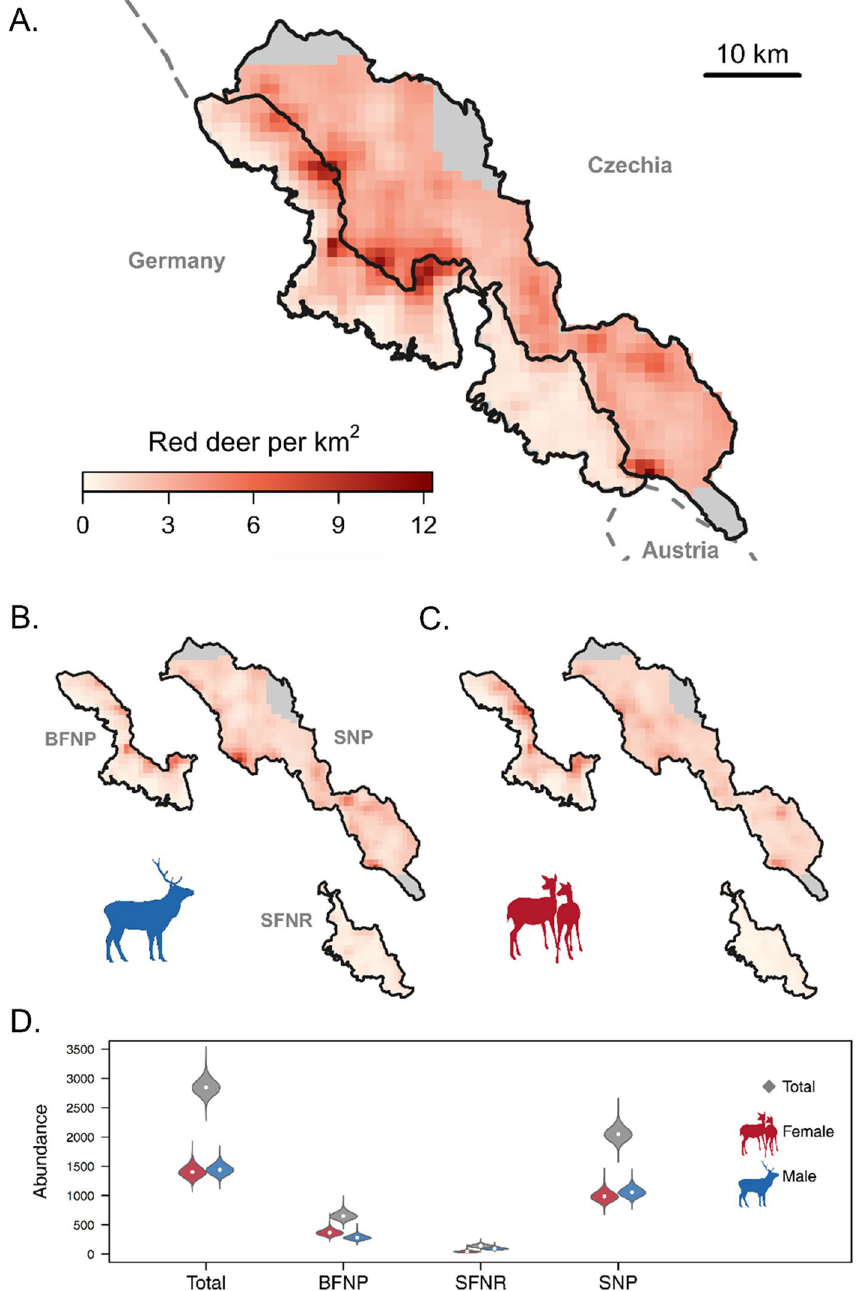
Figure 2. Density maps ( A – C ) and abundance estimates (plot D ) for red deer Cervus elaphus across the Bohemian Forest Ecosystem in summer, June and July, 2018. Population estimates are broken down into sex- specific estimates ( B male, C female deer) for the three administrative units ( BFNP Bavarian Forest National Park, SFNR State Forest Neureichenau, and SNP Šumava National Park). Grey areas in density maps represent regions beyond the sampled extent that belong to the management jurisdictions. Violins in plot ( D ) show posterior distributions of abundance with 95% credible interval and white dot indicates the medians. All figures were created using R 59